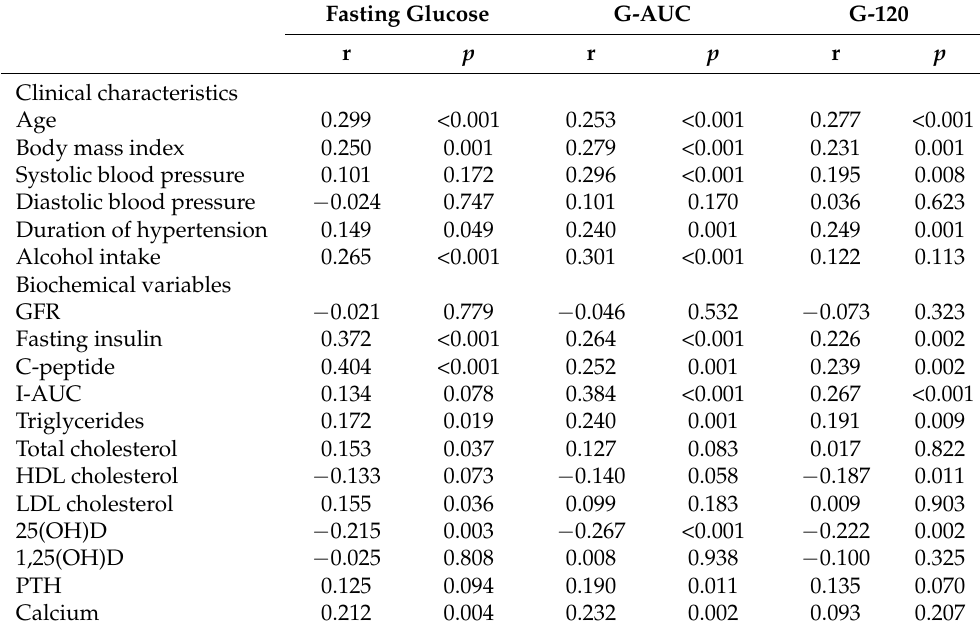
Table 4. Relationships between parameters of glucose metabolism and other study variables. Fasting